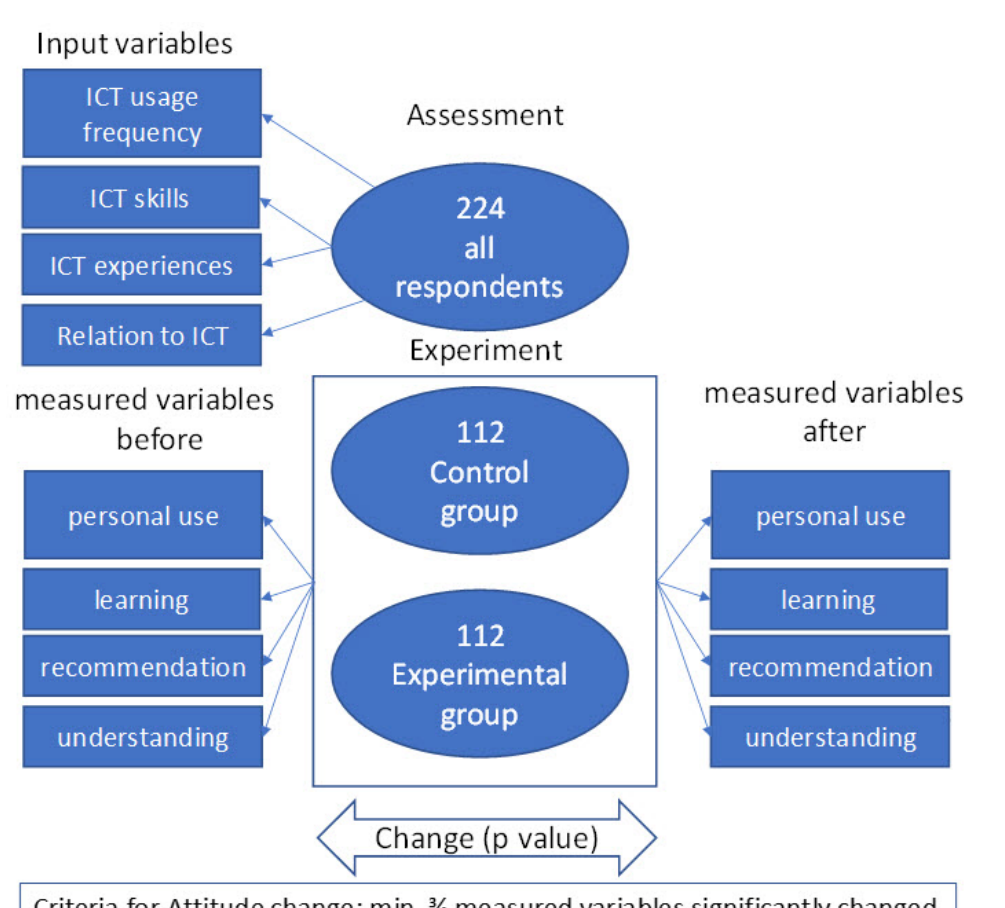
Figure 2. Experiment description schema.